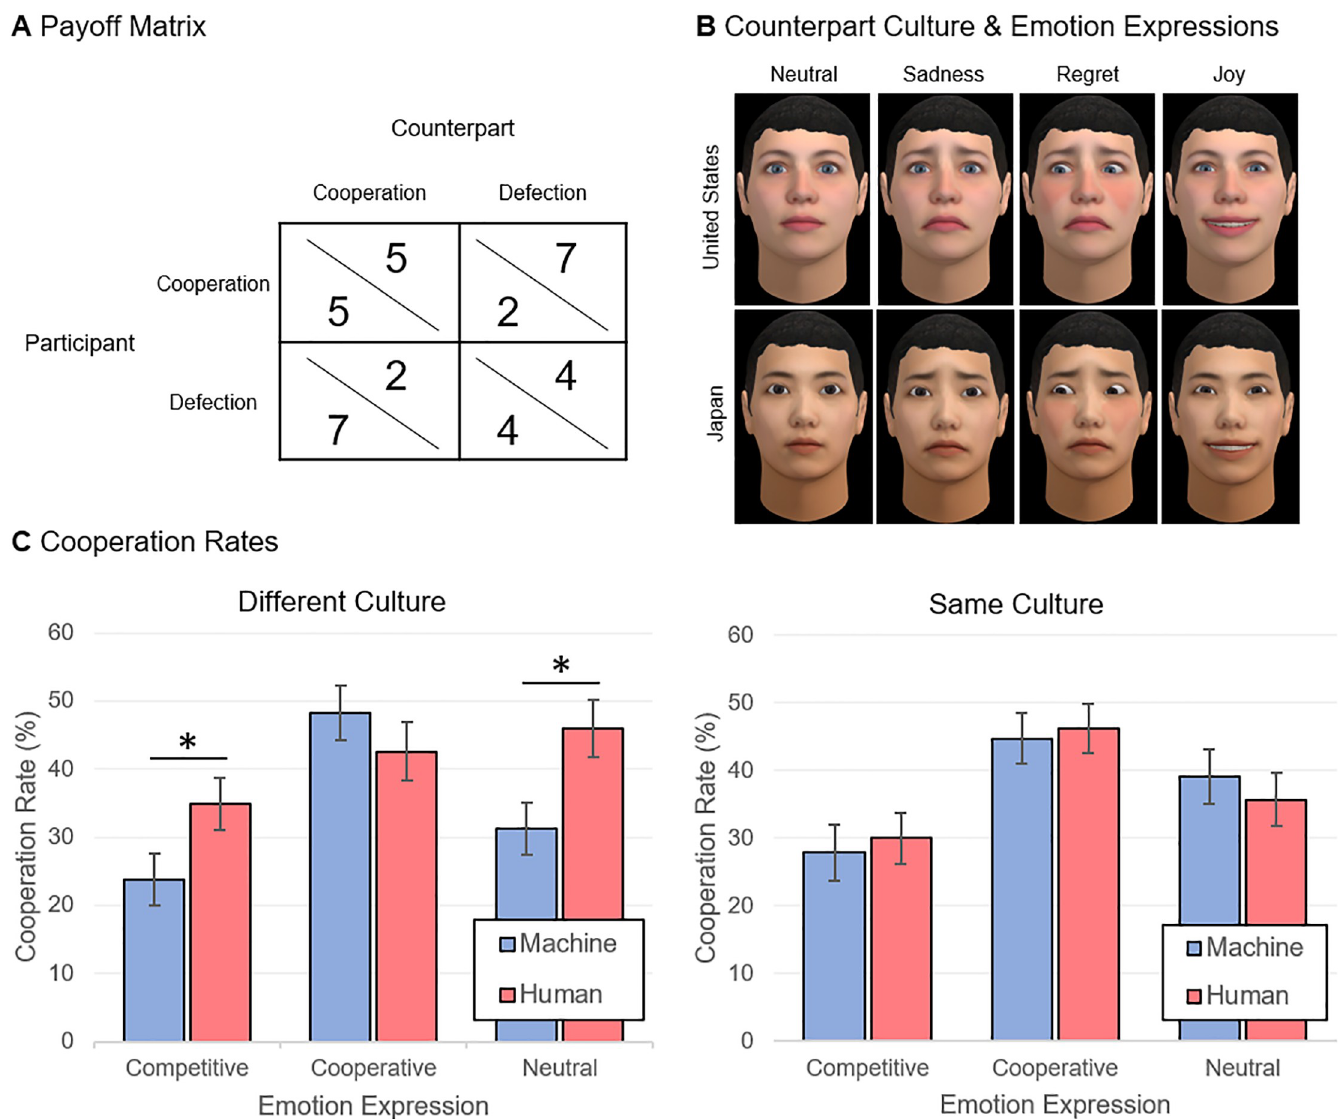
Fig 1. Experimental manipulations and cooperation rates. ( A ) The payoff matrix for the prisoner’s dilemma, ( B ) Counterparts’ virtual faces typical in the United States (top) and Japan (bottom) and corresponding emotion expressions, ( C ) Cooperation rates when the counterpart was from a different culture as the participant (left) or the same culture (right). The error bars correspond to standard errors. � p < .05.